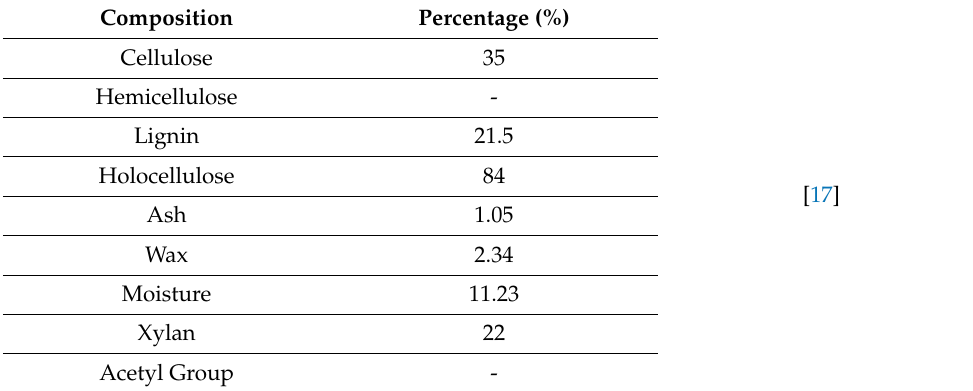
Table 1. Kapok Fiber Chemical Composition.